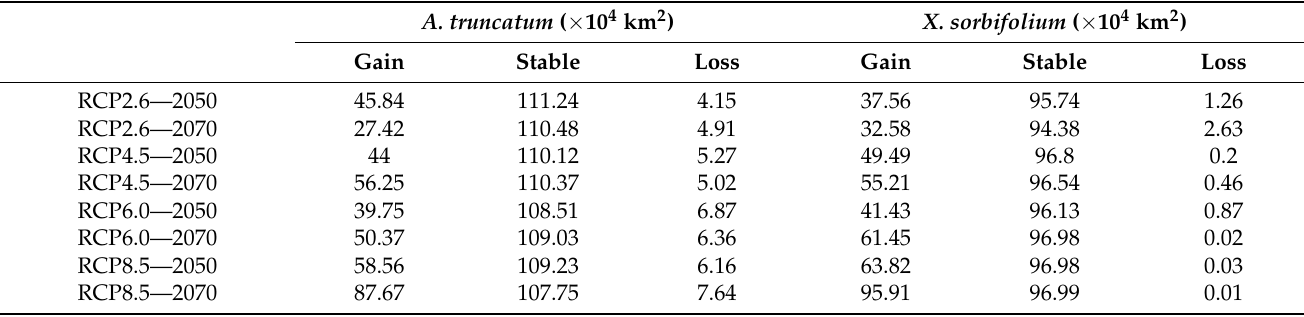
Table 3. Future suitable habitat changes of A. truncatum and X.